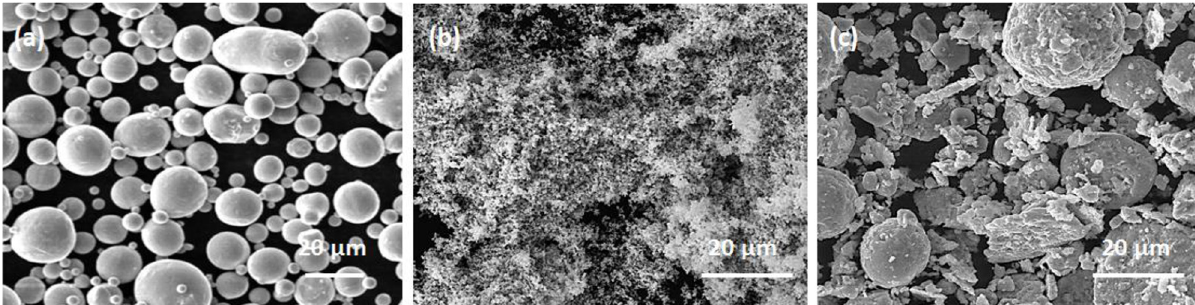
Fig. 1. Morphologies of starting materials: (a) CpTi powder (b) Nb 2 O 5 powder (c) Nb 2 O 5 powder dispersed in